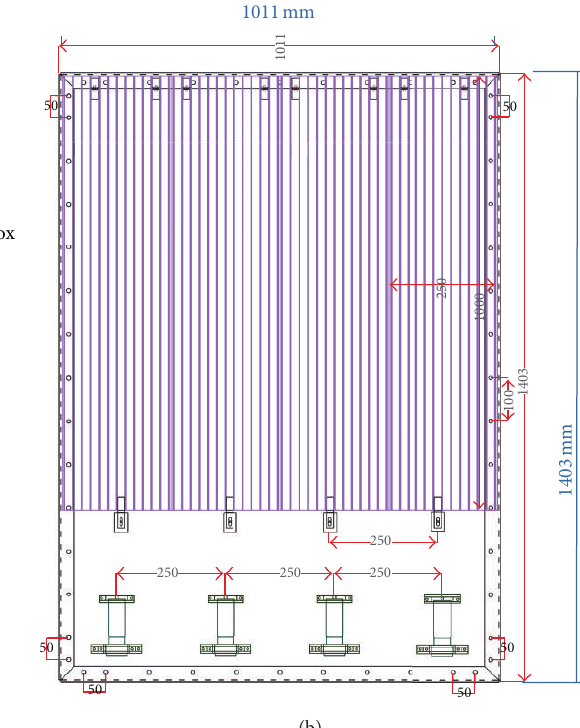
For the former configuration of the mobile detector, two detection modules were used, each module being a scintil- lator plate (NE114 type) of 0.9025 m 2 and 3 cm